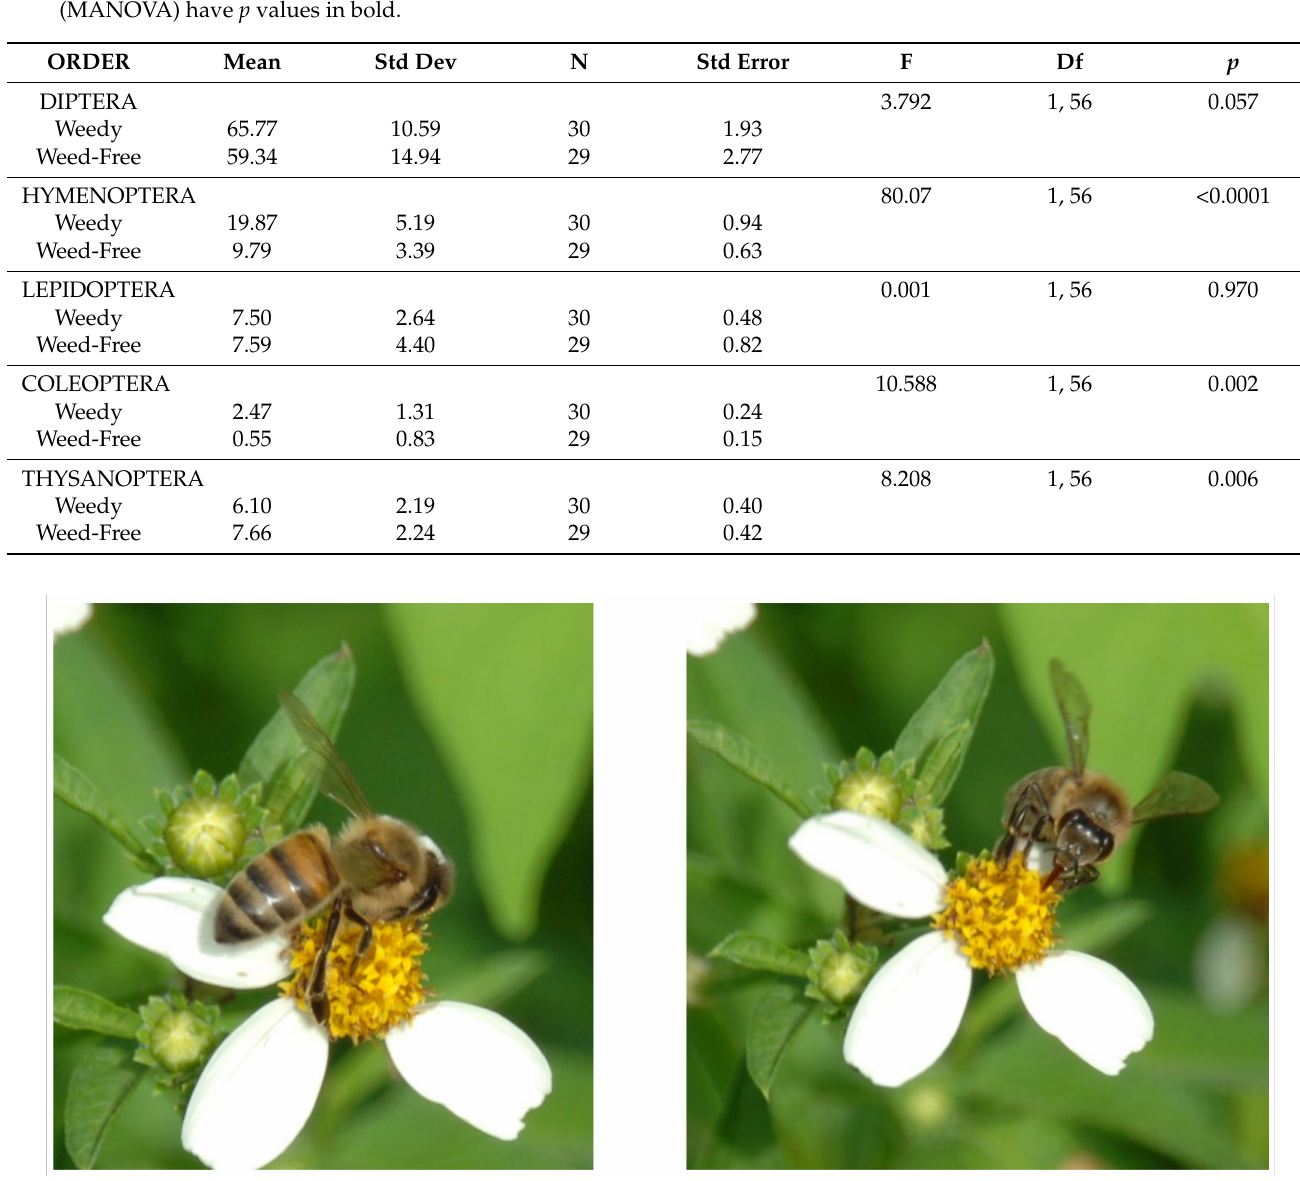
Figure 3. Honeybees ( Apis mellifera ) on Bidens alba , a common native weed in Florida. Additionally, flies were abundant flower visitors, and there were (nearly significantly) more on weedy mango trees than weed-free ones (Table 2, F = 3.79, df = 1, 56, p = 0.057; Figure 4). There were significantly more thrips (Table 2, Thysanoptera F = 8.208, df = 1, 56, p = 0.06) on the weed-free mango trees than the weedy treatment trees. There was a significant difference in beetles (Coleoptera) F = 10.59, df = 1, 56, p = 0.002, with more feeding in the mango flowers with weeds